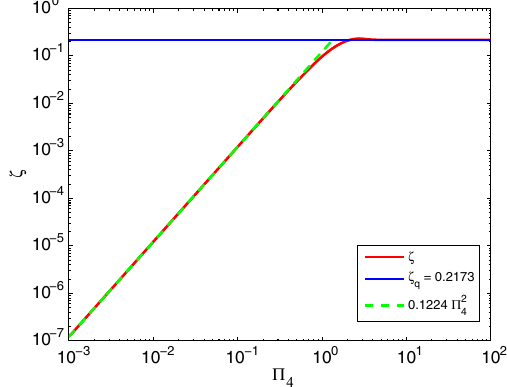
FIG. 1. Position of the peak of stress for the general problem. For Π 4 sufficiently large the peak position matches the quasistatic result.